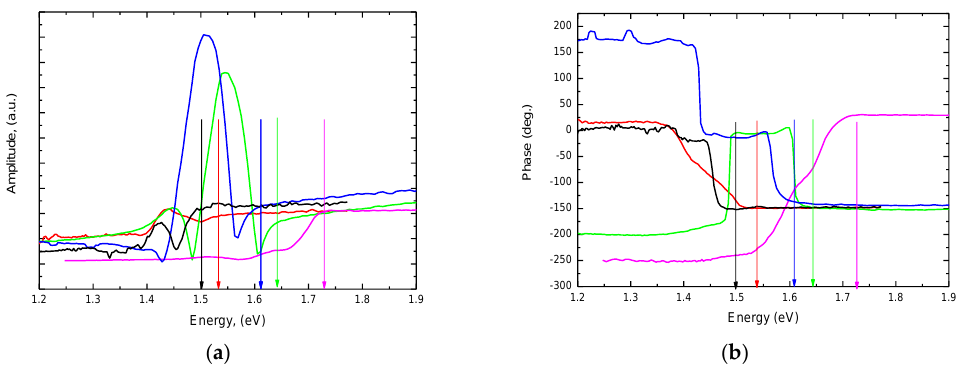
Figure 5. Amplitude ( a ) and phase ( b ) spectra of Cd 1 − x Be x Te for different beryllium content. Black line: x = 0, red: x = 0.01, blue: x = 0.03, green: x = 0.05, magenta: x = 0.1. The color arrows indicate the values of energy gaps. The obtained values of energy gaps are presented in Table 1. Table 1. The experimental values of E g for Cd 1 − x Be x Te.